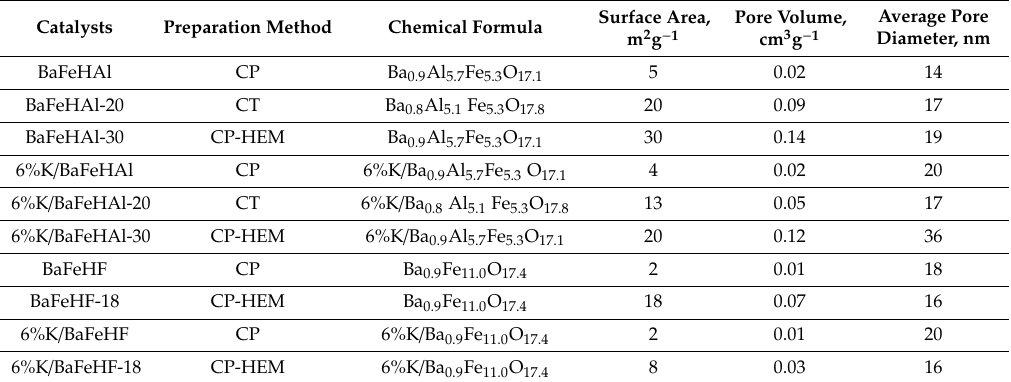
Table 1. Composition and texture parameters of BaFeHAl and BaFeHF materials tested in CO 2 splitting by chemical looping.